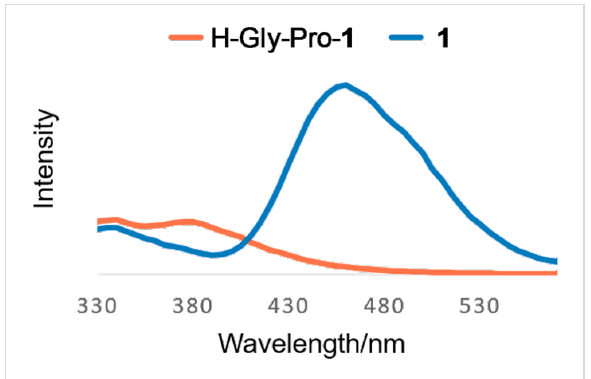
Figure 3: Fluorescence spectra of 1 and H-Gly-Pro- 1 . Measurement conditions: 1.0 × 10 − 5 M in H 2 O:DMSO (9:1), excitation at λ = 300 nm.